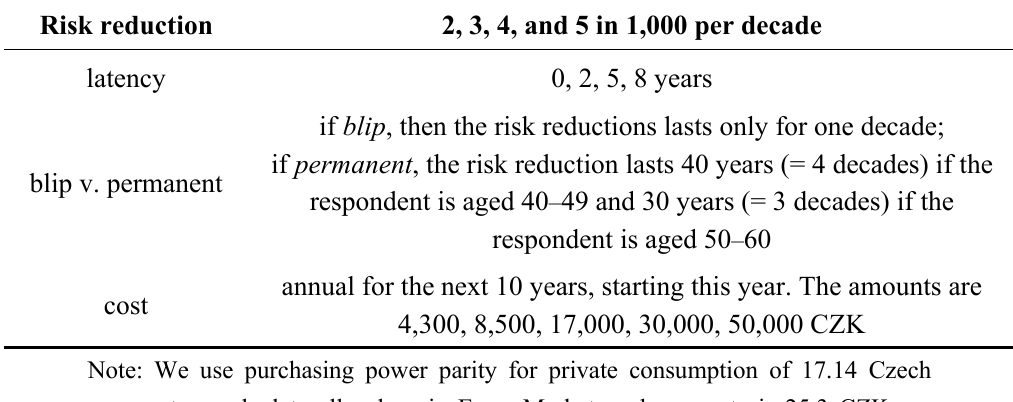
Table 1. Attributes and attribute levels of the discrete choice